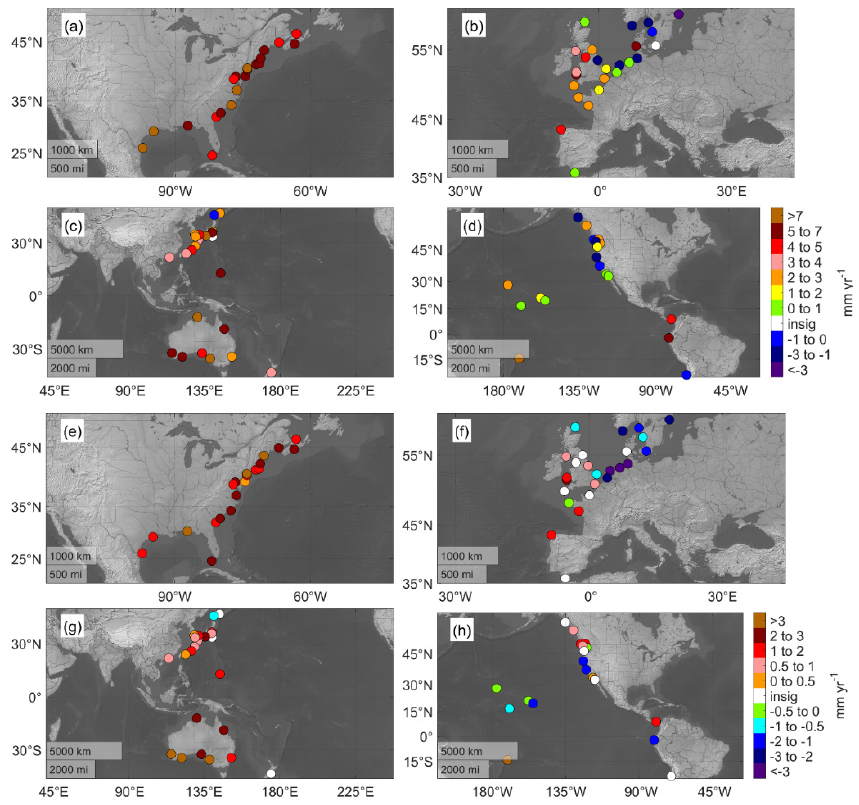
Figure 5. ( a – d ) Peak extended water level trends over the past 50 years (PEWL50). ( e – h ) Differences between PEWL and MEWL trends (EWL50_diff). All units are in mm yr − 1 following the color bars at the bottom right; different color scales are used in other plots (from [350] ).